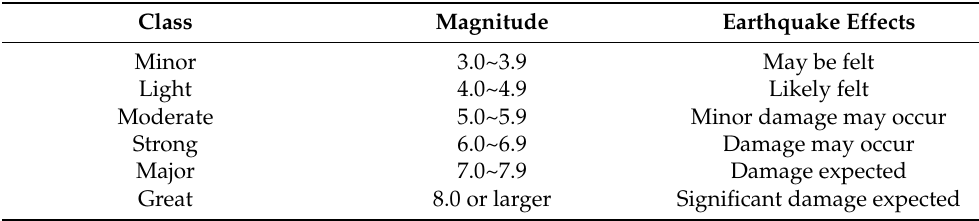
Table 3. Earthquake magnitude classes ranging from minor to great.